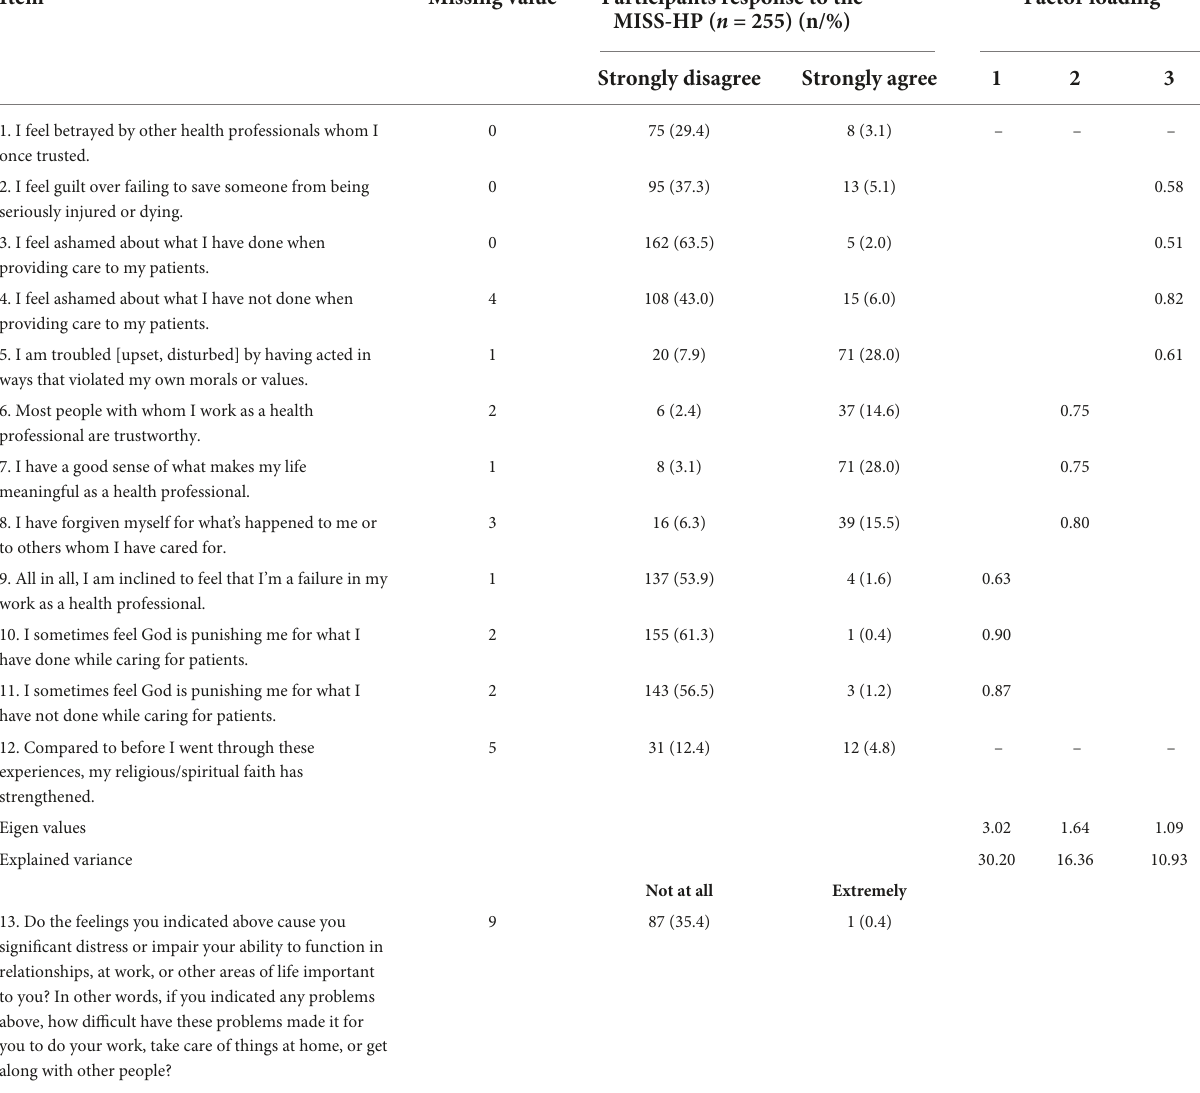
TABLE 3 Data description and exploratory factor analysis of the Persian Version of the Moral Injury Symptoms Scale-Health Care Professionals